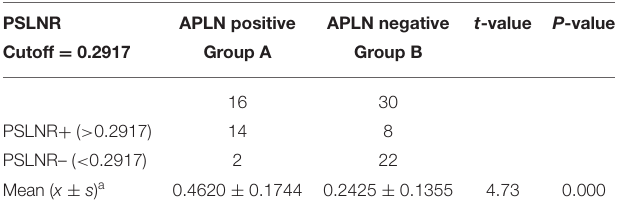
TABLE 6 | PSLNR comparison between groups according to